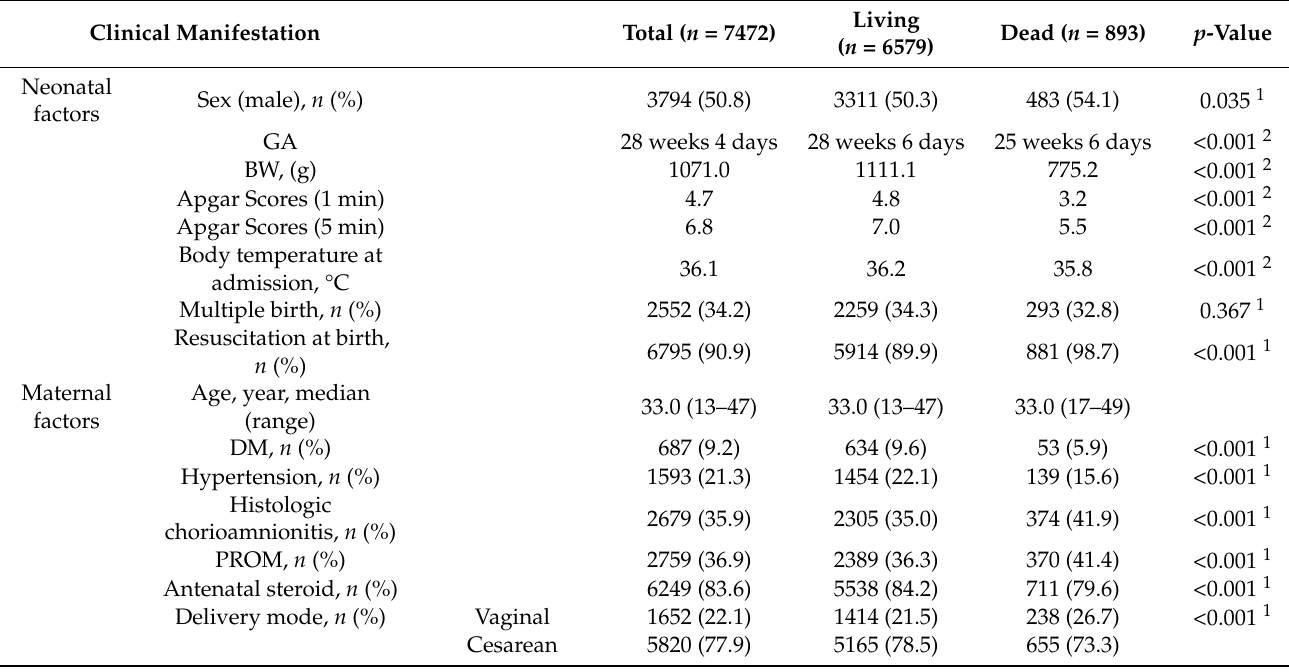
Table 1. Clinical characteristics of the living and dead groups of KNN